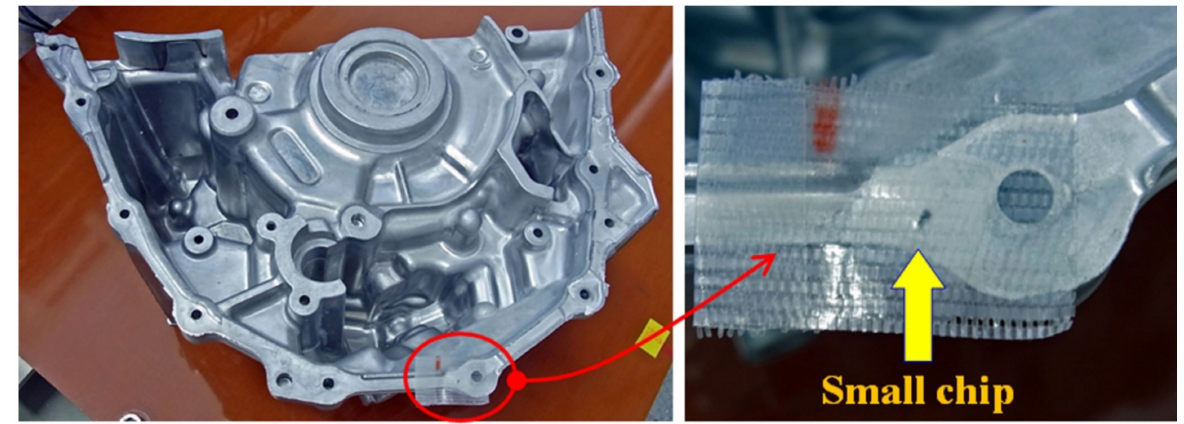
Figure 15. Photograph of the small steel chip mounted on the end-flange of an aluminum casting with a complex shape.